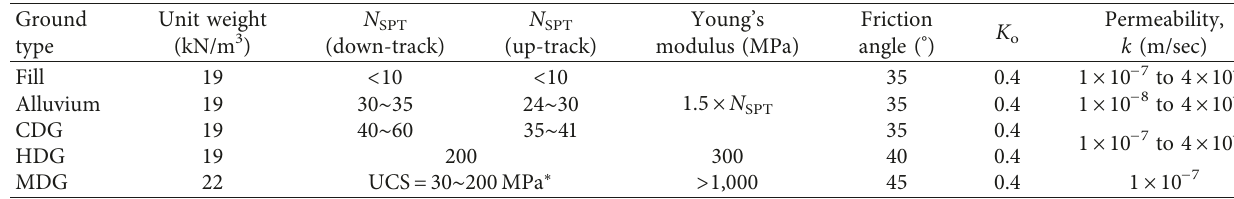
Figure 1: Tunnel alignment and geological profile. Table 1: Geotechnical design parameters of the ground.